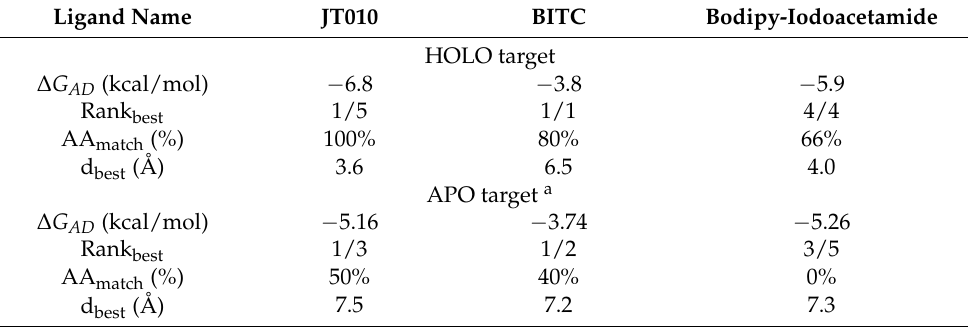
Table 3. Non-covalent docking calculations performed by AutoDock 4.2